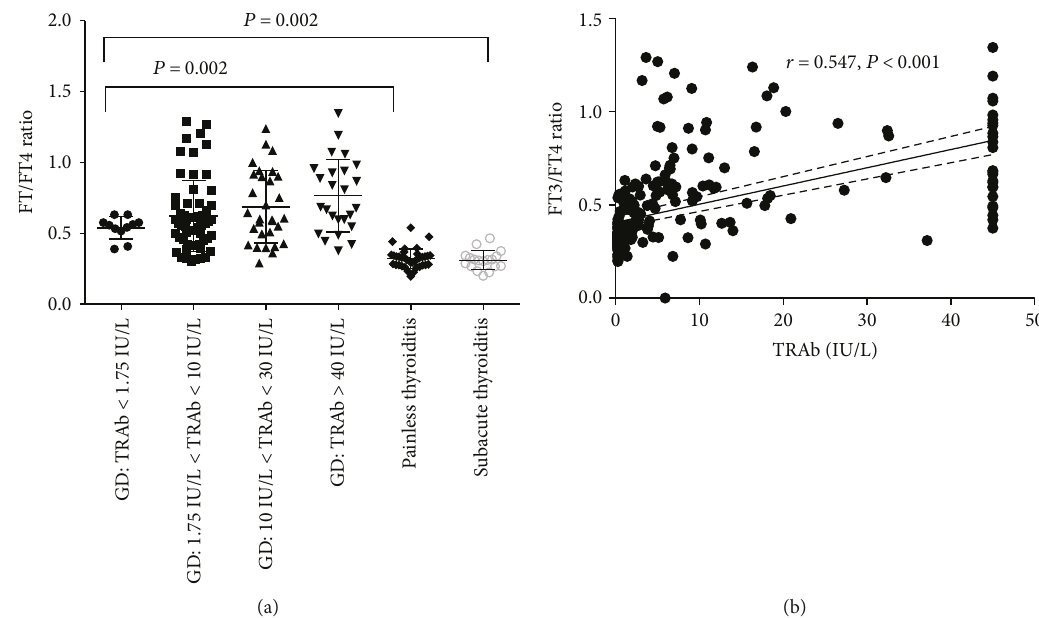
Figure 2: Correlation between FT3/FT4 ratio and TRAb. (a) shows FT3/FT4 ratios for di ff erent TRAb titers in patients with Graves ’ disease as well as the FT3/FT4 ratios for patients with painless thyroiditis and subacute thyroiditis. (b) shows correlation between FT3/FT4 ratio and TRAb titer.